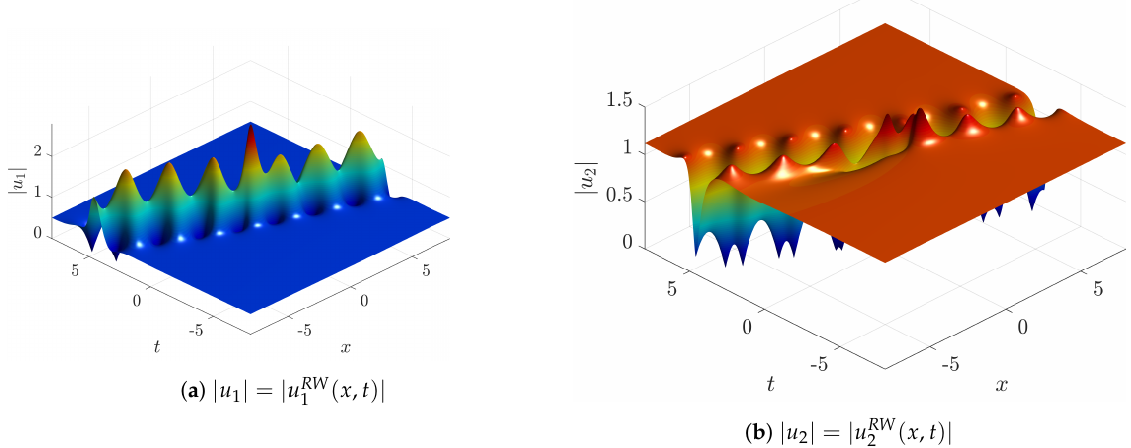
Figure 11. Semi-rational solutions corresponding to the spectrum 0 G 2 B 1 L , for a choice of c , c 1 , c 2 that maximises the amplitude of | u 1 | . q = 1, s 1 = s 2 = − 1 (focussing), r = 1, p = − 1.5 ( a 1 = 0.5, a 2 = 1.118); λ c = 0.45209 + 1.1448 i , c = 1, c 1 = − 0.16318 + 1.0573 i , c 2 = 2.0913 + 1.5656 i , ( x , t ) | / a = 5.5792, max | u RW ( x , t ) | / a = max | u RW 2 1 2 1